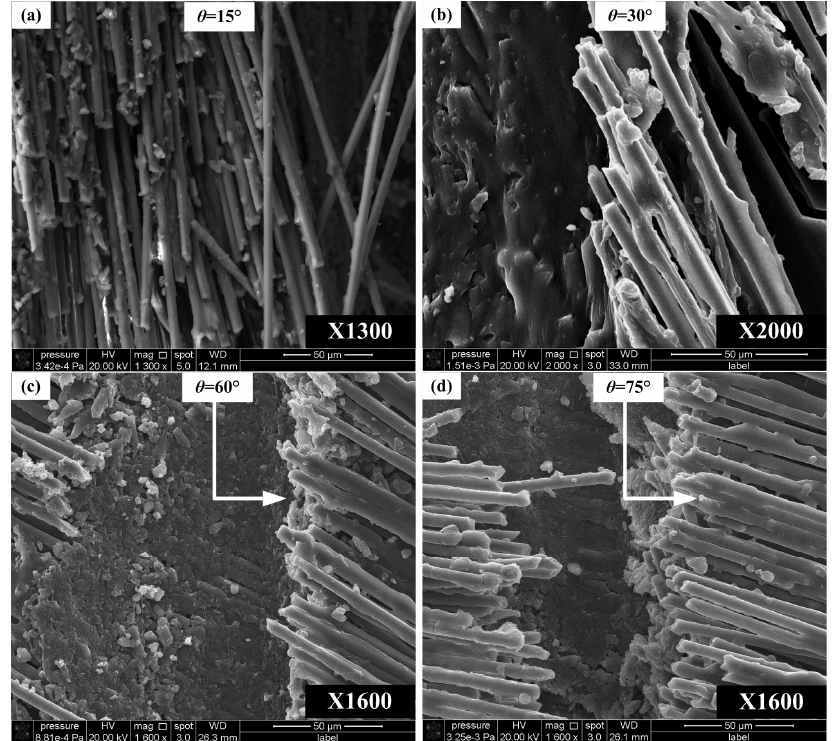
Figure 13. Fracture topography SEM photos of carbon fiber with orientation angles along fiber direction. ( a ) 15° orientation angle with 1300X magnification; ( b ) 30° orientation angle with 2000X magnification; ( c ) 60° orientation angle with 1600X magnification; ( d ) 75° orientation angle with 1600X magnification.